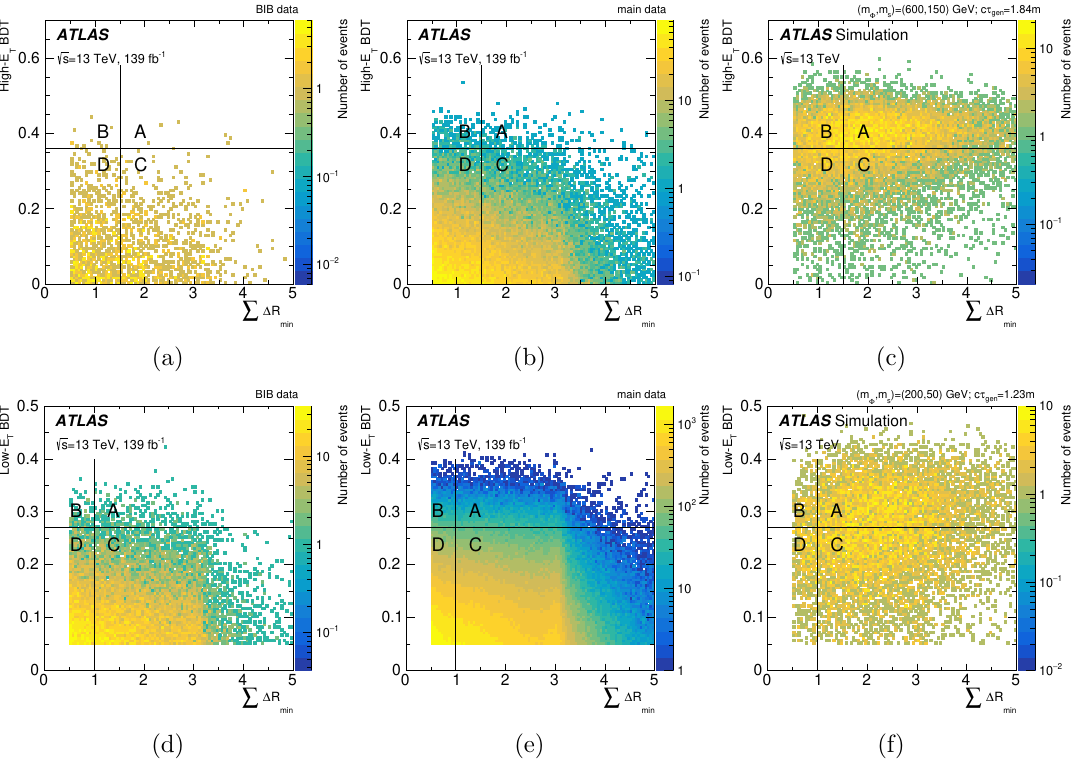
Figure 8. The distributions of P ∆ R min (jet, tracks) vs high- E T BDT for (a) BIB events, (b) main data and (c) a signal sample after event cleaning for the high- E T selection. Panels (d,e,f) show the equivalent distributions for the low- E T selection. The signal sample with m Φ = 600 GeV and m s = 150 GeV is shown for the high- E T selection, while the sample with m Φ = 200 GeV and m s = 50 GeV is shown for the low- E T